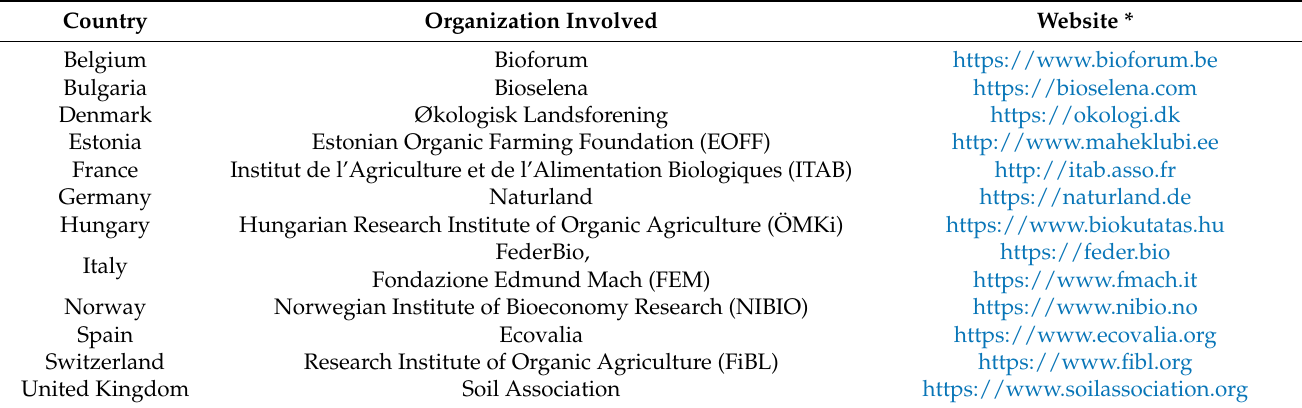
Table 1. Institutes involved in this expert